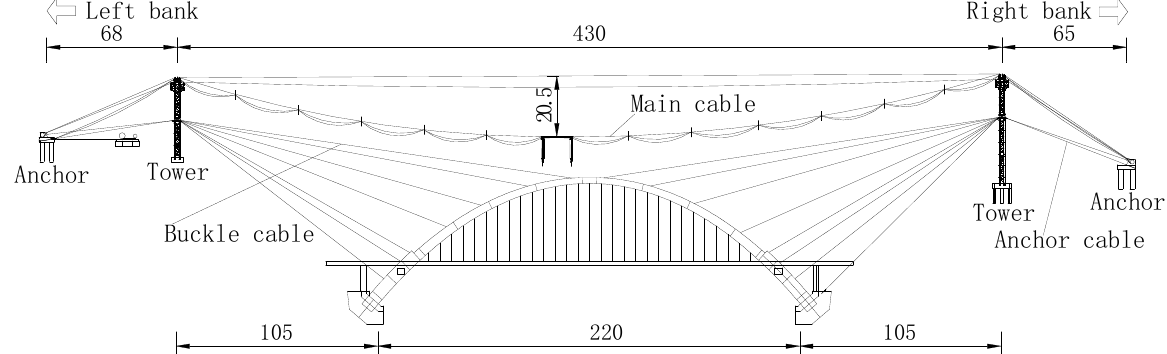
Figure 6. Overall layout of cable lifting system.